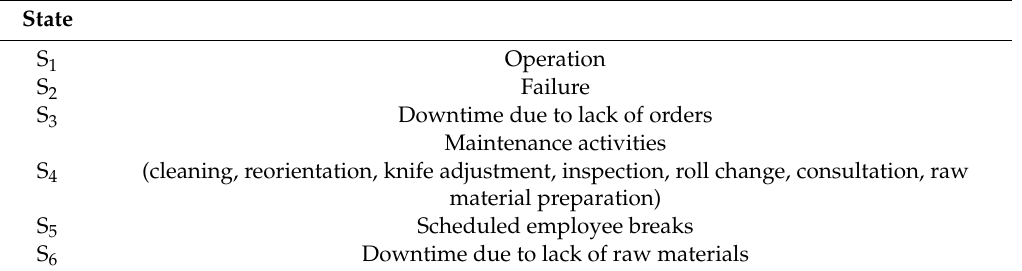
Table 1. Operating states under consideration.